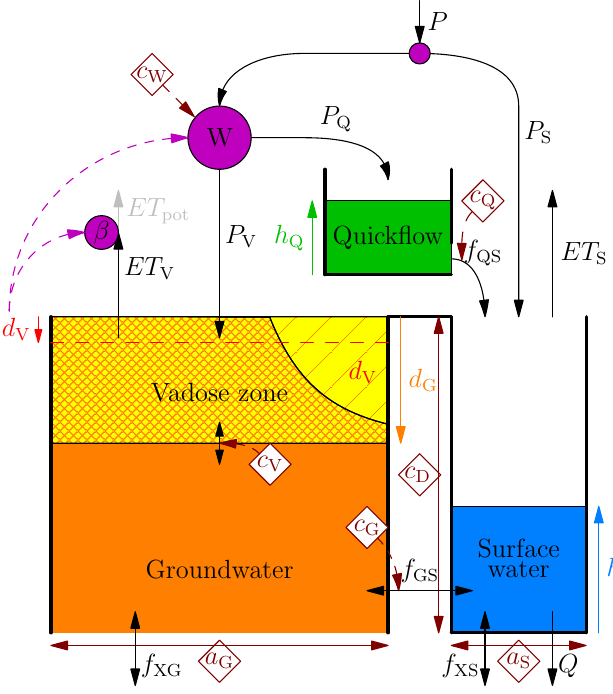
Figure 4. Overview of the model structure with the five compart- ments: land surface (purple), vadose zone within the soil reservoir (yellow/red hatched), groundwater zone within the soil reservoir (orange), quickflow reservoir (green) and surface water reservoir (blue). Fluxes are black arrows, model parameters brown diamonds and states in the colour of the reservoir they belong to. For a com- plete description of all variables, see Table 1 and Sect. 5.1. The names of the fluxes are derived from the reservoirs (for example f XS : f stands for flow, the X for external and the S for surface water – water flowing from outside the catchment into the surface water